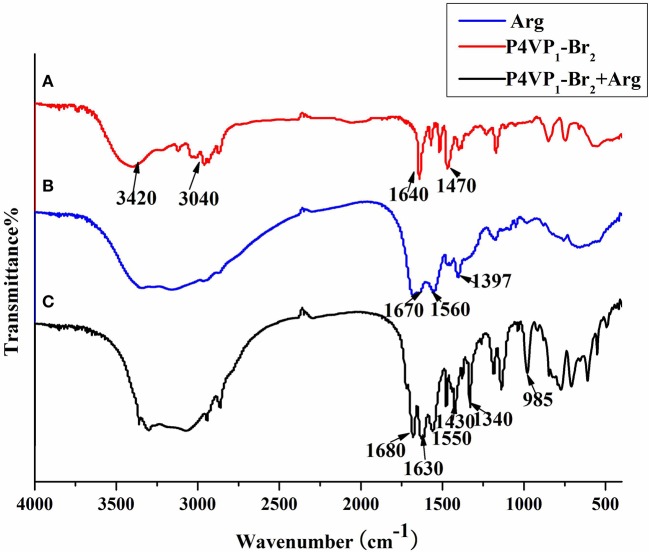
FTIR of P4VP1-Br2
(A), L-Arg (B), and P4VP1-Br2 after combining with L-Arg (C).